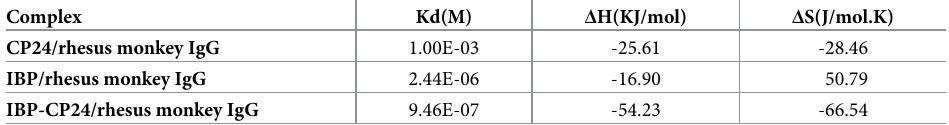
Table 1. Thermodynamic parameters of CP24, IBP or IBP-CP24 binding to rhesus monkey IgG, as determined by ITC. Complex